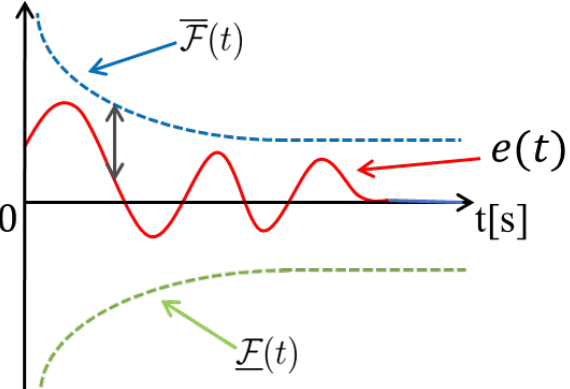
Figure 5. Concept of funnel